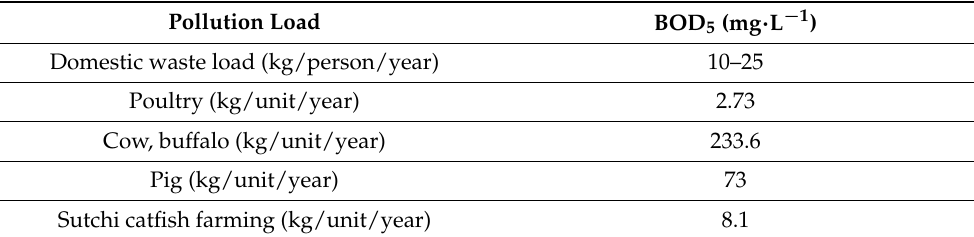
Table 2. Pollution load